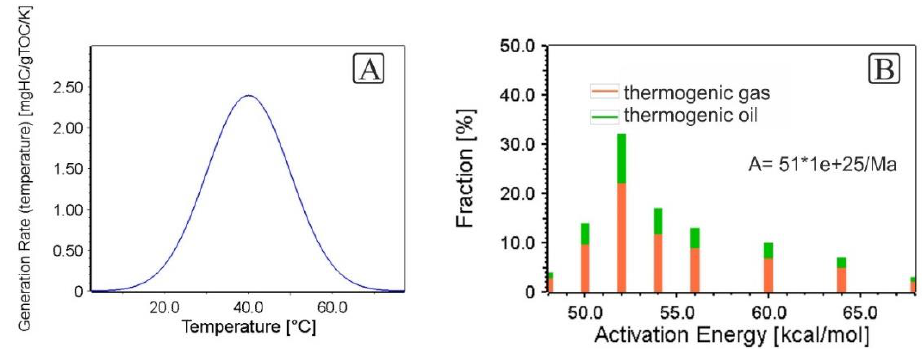
Figure 5. Kinetic models of ( A ) biogenic and ( B ) thermogenic gas generation processes used in numerical model of Miocene sedimentary basin.